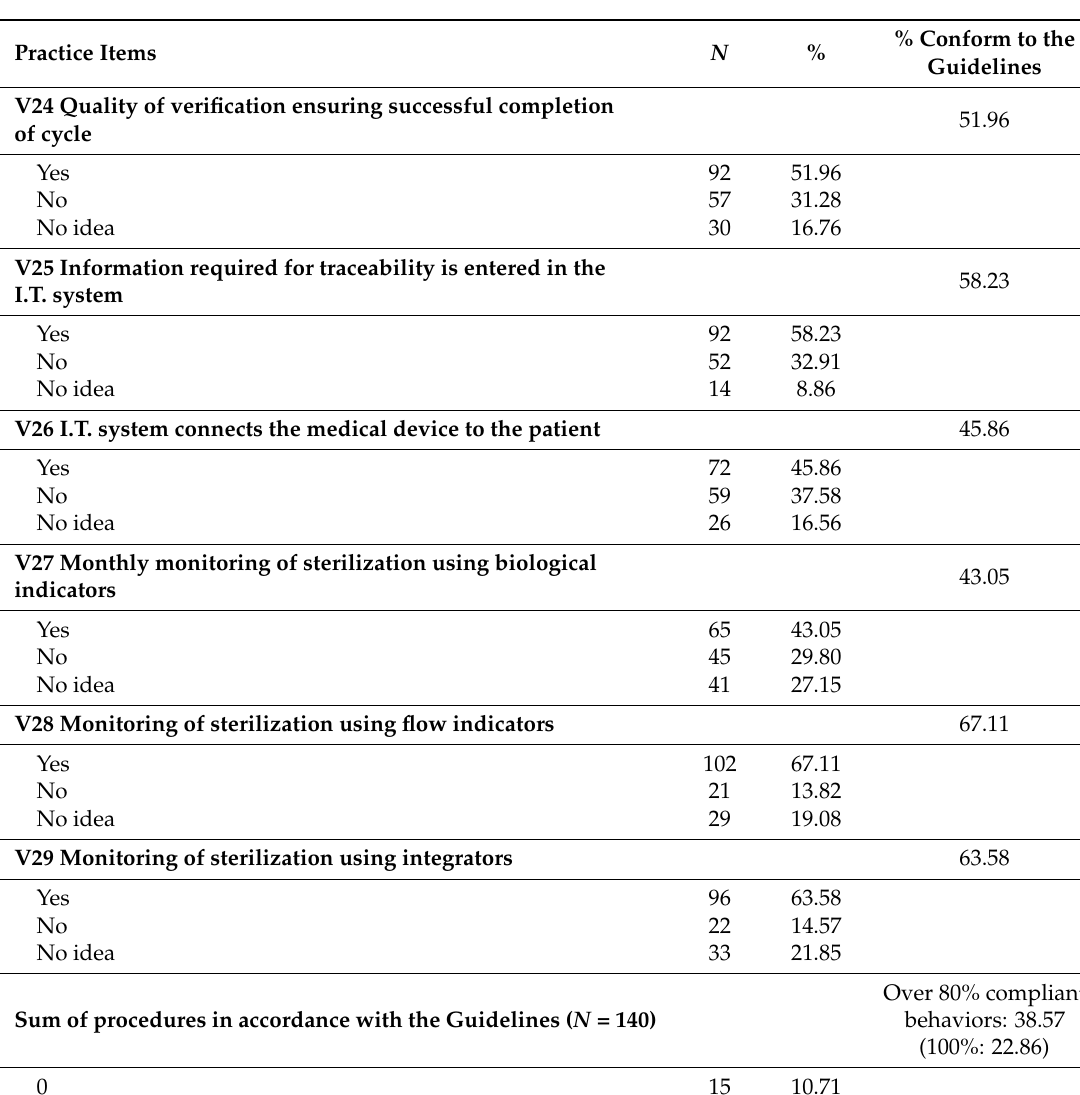
Table 4. Descriptive analysis: Monitoring and documentation of sterilization procedure—Tracking and tracing the instrumentation (Group 4) ( N =